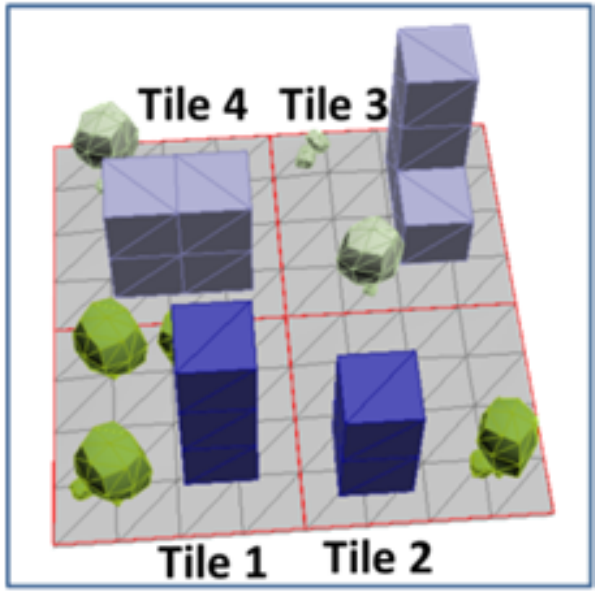
Figure 8. Organization of a model city using a regular